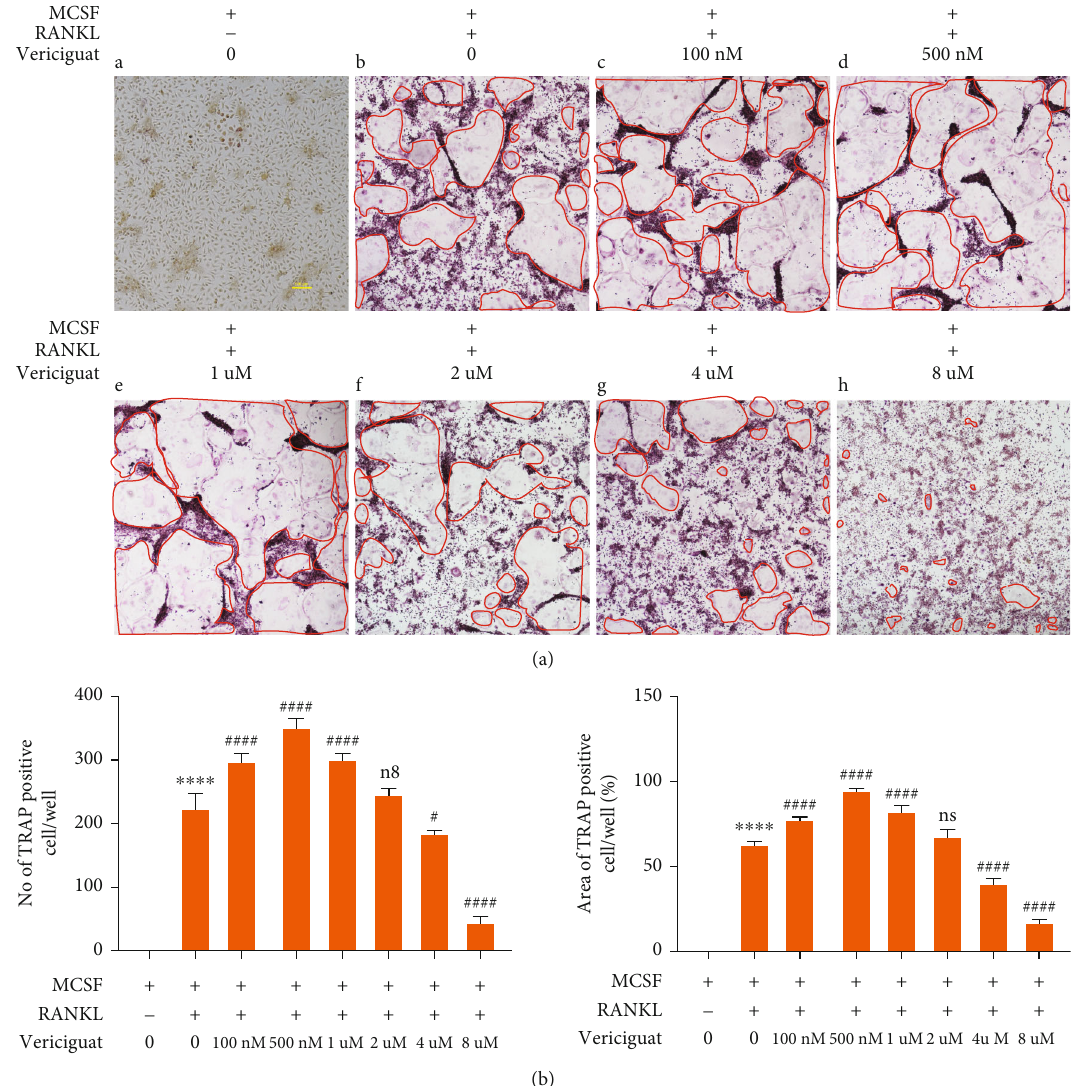
Figure 2: Vericiguat dually regulated RANKL-triggered osteoclast formation in vitro. (a) Representative images of TRAP-positive osteoclasts (red circles) after stimulation with RANKL and indicated concentrations of Vericiguat ( n = 3 ). Image was used as the negative control (BMMS without RANKL). (b) The number and the size of TRAP + multinucleated osteoclasts were quanti fi ed. n = 3 means three independent experiments. ∗ indicated a comparison with the control group (without RANKL and Vericiguat): ∗ p < 0 : 05 , ∗∗ p < 0 : 01 , ∗∗∗ p < 0 : 001 , and ∗∗∗∗ p < 0 : 0001 . # indicated a comparison between the group with RANKL only and the group with RANKL and Vericiguat: # p < 0 : 05 , ## p < 0 : 01 , ### p < 0 : 001 , and #### p < 0 : 0001 . ns: not statistically signi fi cant. Scar bar = 100 μ m